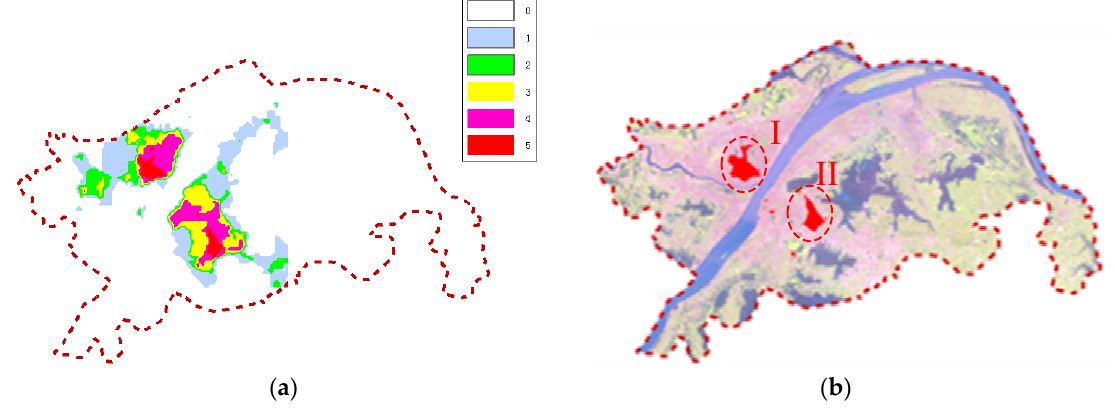
Figure 11. Clustering results of restaurants and their locations in Wuhan’s Central District. ( a ) Thematic map by the overlay analysis. ( b ) Regions with the largest overlaying layers in Wuhan.